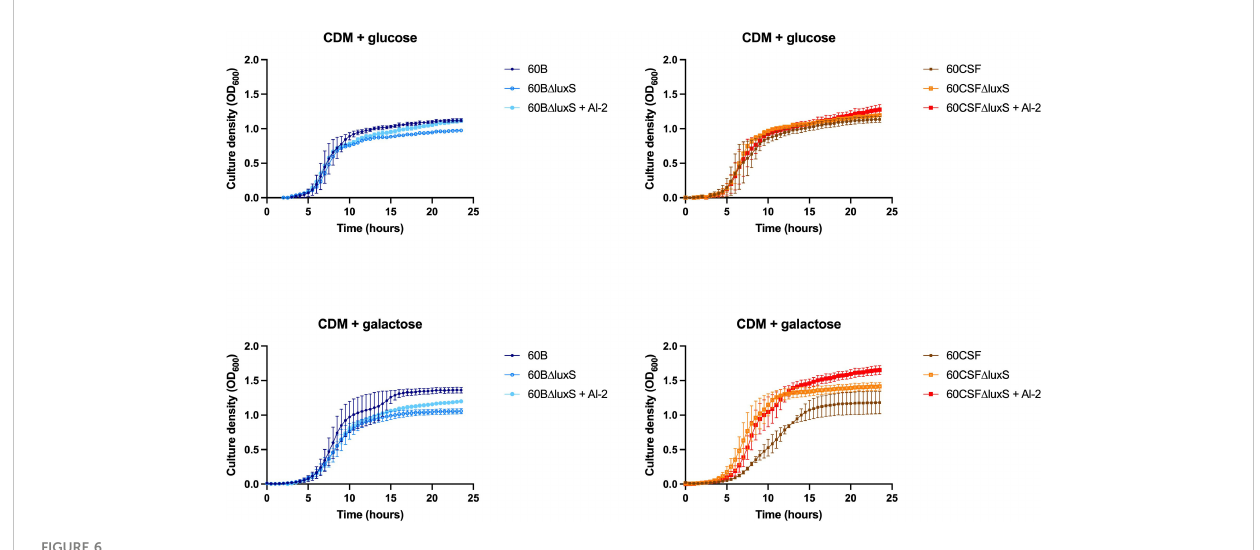
FIGURE 6 Impact of AI-2 on growth of luxS mutants. 60B, 60CSF, 60B D luxS and 60CSF D luxS were grown in 200 µL CDM supplemented with 0.5% glucose (CDM + glucose) or 0.5% galactose (CDM + galactose). OD 600 was measured every 30 min for 24 h. Data are mean OD 600 ± standard error mean (SEM) from two independent assays, each performed in